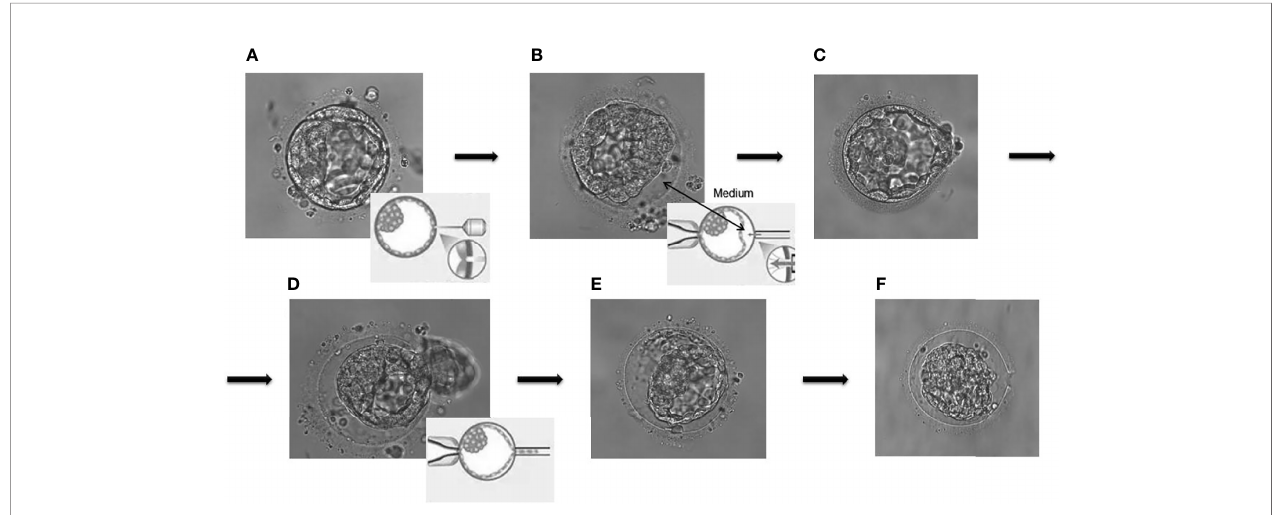
FIGURE 2 | The common procedure for non-assisted hatching trophectoderm biopsy. (A) Laser drilling; (B) arti fi cial separation by injection of culture medium; (C, D) pulling and suction; (E, F) the remaining blastocyst components collapsed in the zone